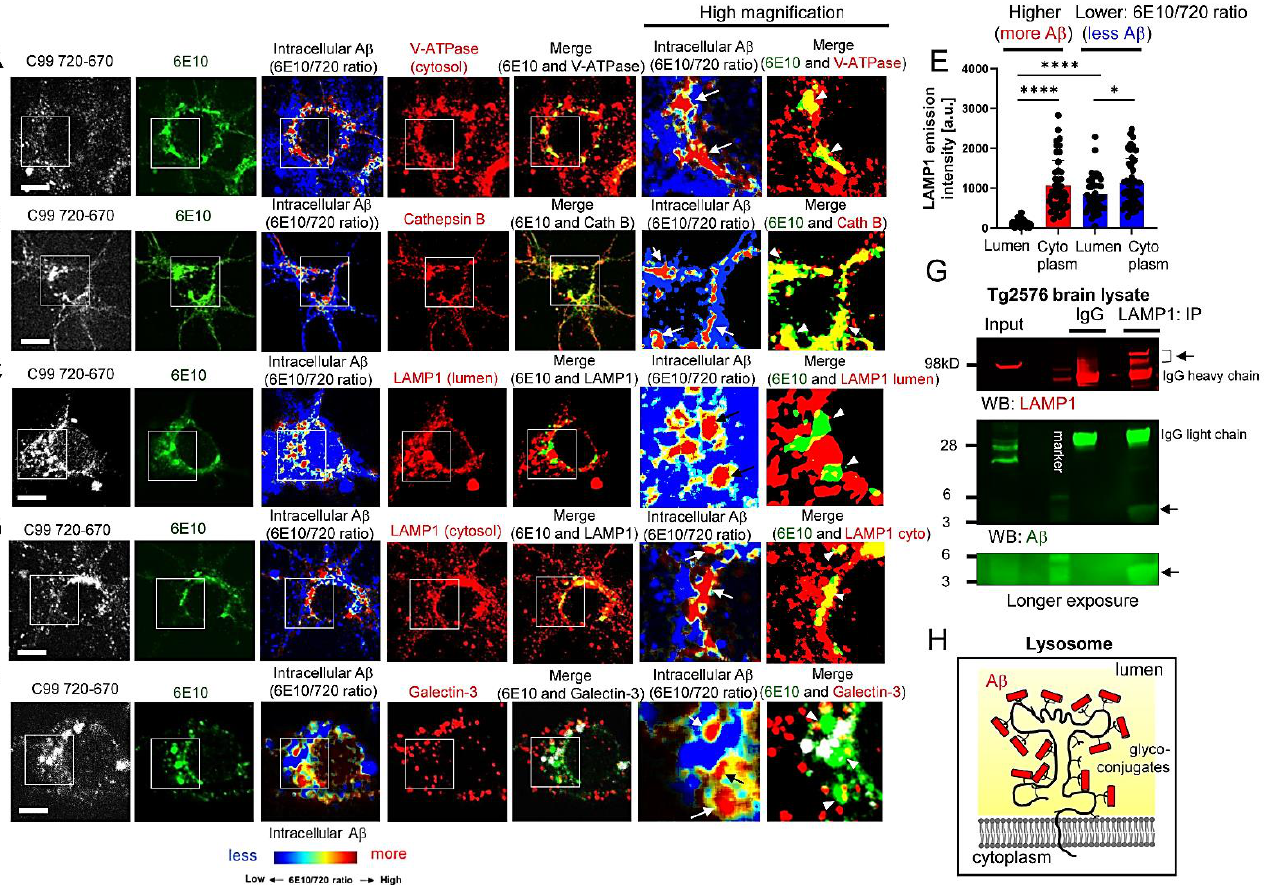
Figure 2. A β is bound to glycoproteins on the inner leaflet of lysosome membrane. ( A ) Neurons expressing the C99 720-670 biosensor were co-stained with 6E10-Alexa488 and Cy3-labeled V-ATPase, ( B ) Cathepsin B, ( C ) LAMP1 (lumen epitope), or ( D ) LAMP1 (cytoplasmic epitope). Scale bar: 10 µ m. ( E ) LAMP1-Cy3 emission intensity was measured in the ROIs with high or low 6E10 Alexa488/C99 720-670 ratios (44 – 50 ROIs from 5 – 8 neurons, * p < 0.05, **** p < 0.0001). Arbitrary unit: a.u. ( F ) Post-treatment with 50 µM chloroquine for 2 h to induce lysosome membrane rupture, the neurons were co-stained with Alexa488-6E10 and Cy3-Galectin 3. Scale bar: 10 μm. ( G ) Tg2576 mouse brain lysate was immunoprecipitated with the LAMP1 cytoplasmic or normal IgG antibodies, followed by Western blotting using A β 6E10 and 4G8 antibodies. ( H ) Schematic presentation: A β binds to the glycoconjugates of lysosomal proteins located on the inner leaflet.